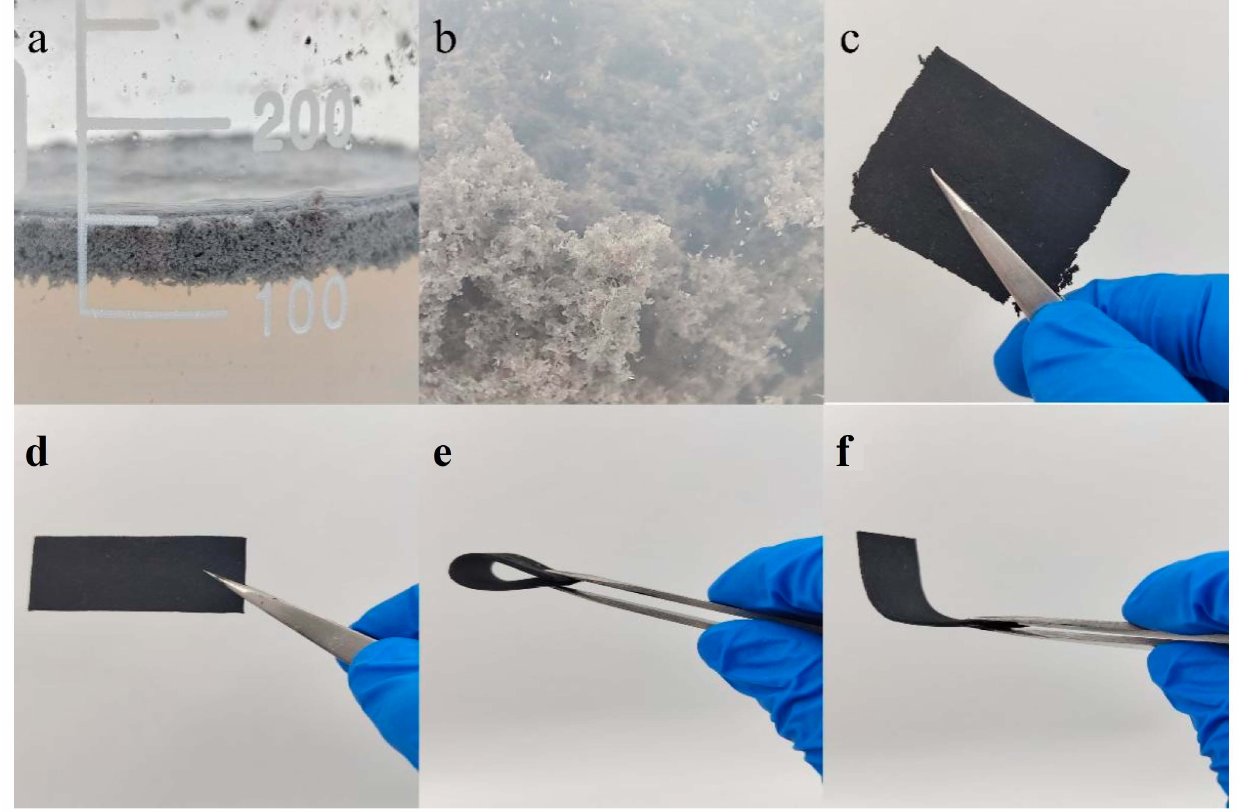
Figure 2. Diagram of CNTs/OCWPU preparation process. ( a , b ) are local enlargements in Figure 1, respectively, ( c – f ) are different morphologies of 10% CNTs/OCWPU after film